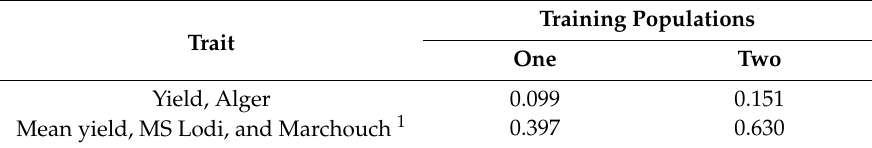
Table 4. Cross-population predictive ability of the top-performing of models constructed by Bayesian Lasso or Ridge Regression BLUP for breeding value of pea lines belonging to three connected RIL populations, for grain yield in the agricultural site of Alger (Algeria) and mean grain yield across a managed drought stress (MS) environment (Lodi, Italy) and the site of Marchouch (Morocco). Average predictions for one RIL based on model training on data of one or two other connected RIL populations. Training Populations Trait One Two Yield, Alger 0.099 0.151 Mean yield, MS Lodi, and Marchouch 1 0.397 0.630 Averaged across results for three RIL populations encompassing 288 lines overall, considering models with five possible thresholds of genotype SNP missing data (10%, 20%, 30%, 40%, 50%). 1 Using phenotypic data averaged across the two